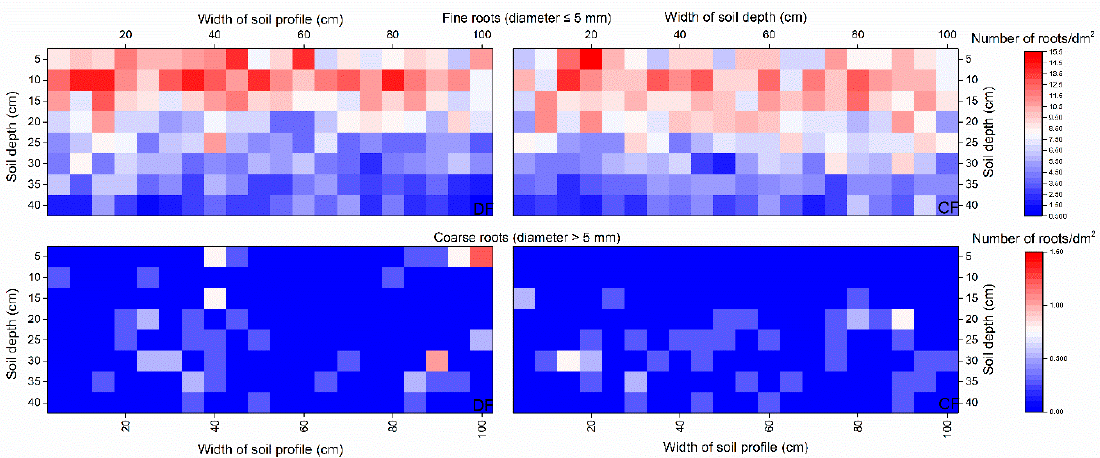
Figure 4. Root abundance ( RA ) of fine and coarse roots in soil profiles. DF: deciduous forest; CF: coniferous forest.